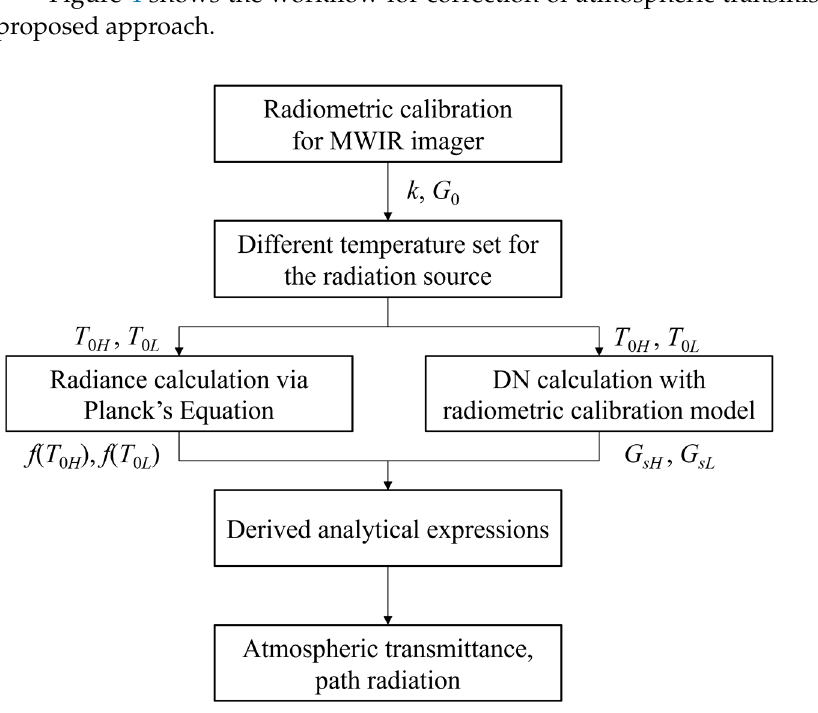
Figure 4. Workflow for the proposed method.